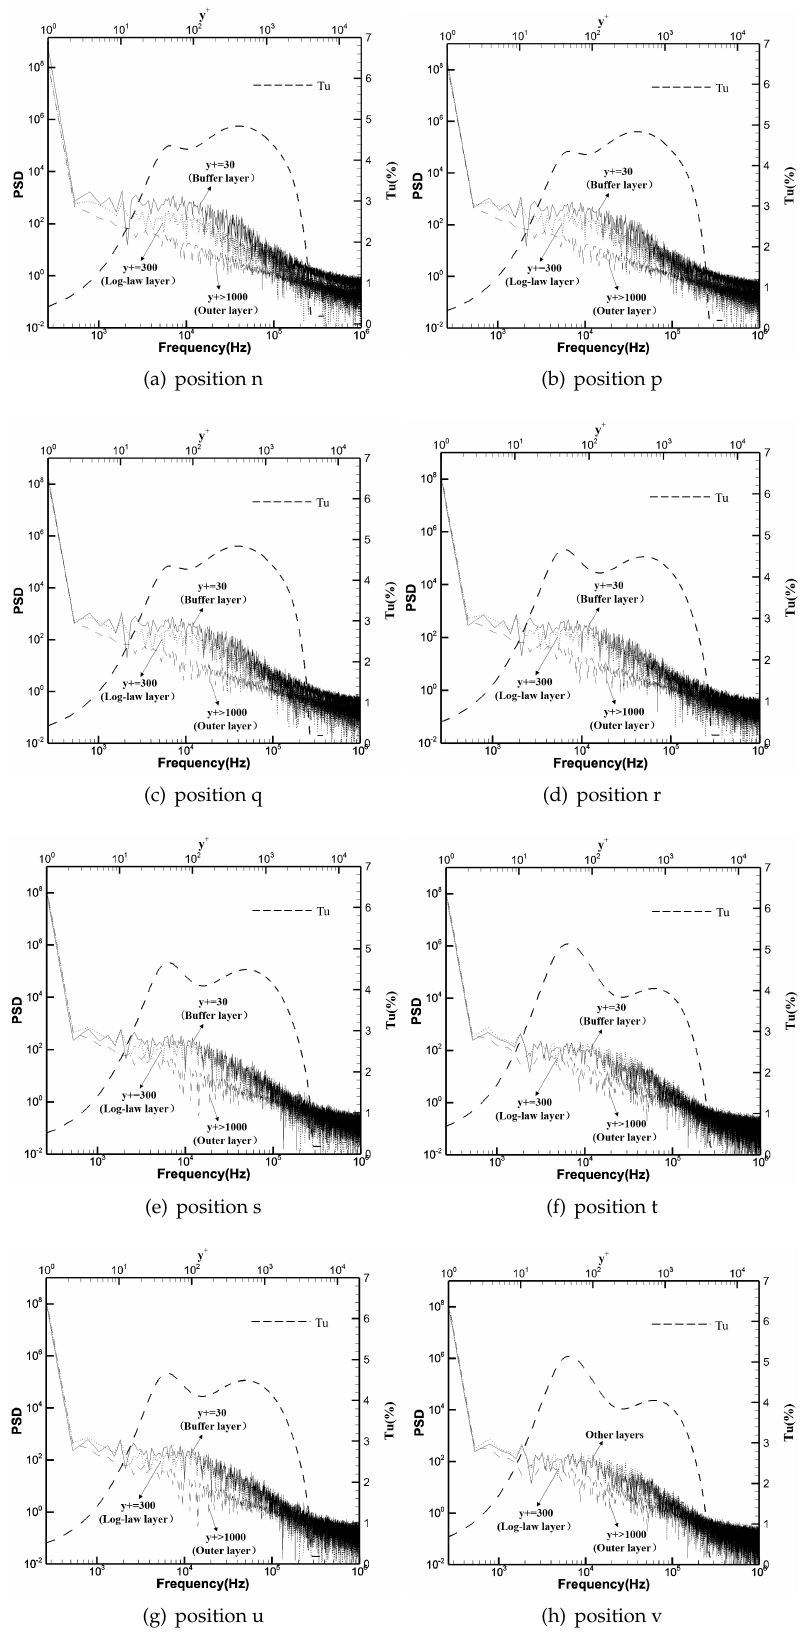
Figure 11. PSD and turbulent intensity at positions